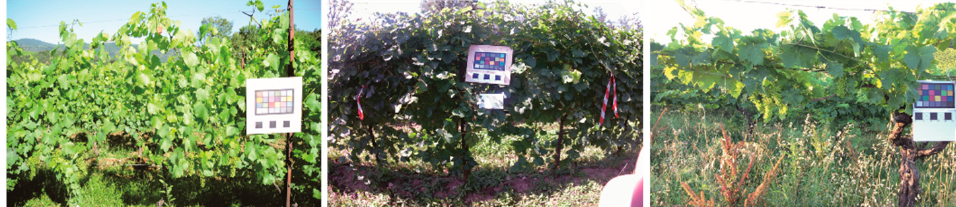
Figure 2. Grapes under different light conditions.